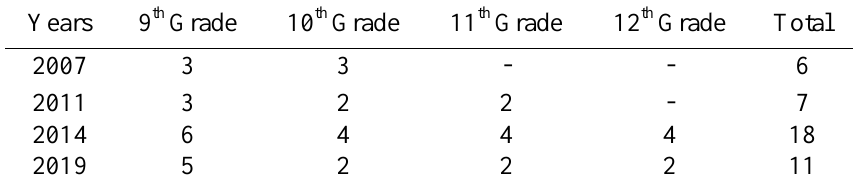
Table 2. English course hours by years in maritime vocational high schools Years 9 th Grade